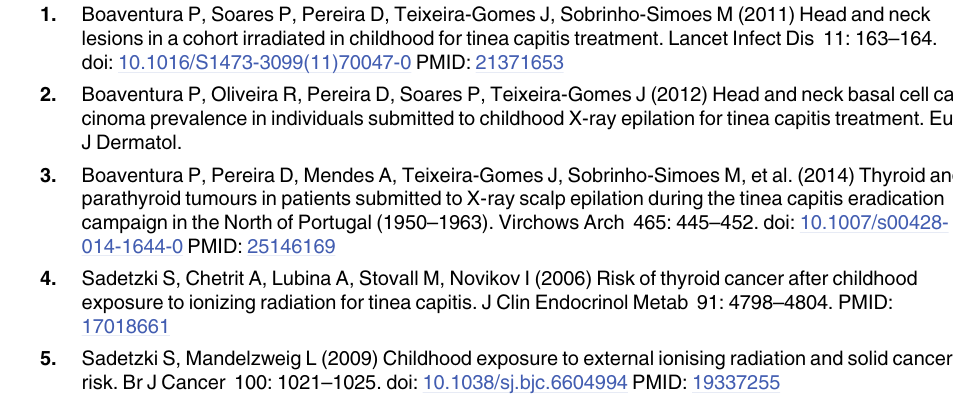
S3 Table. P-values obtained for the adjustment variables in the hereditarymodels analyzed in the atherosclerosisstudy (non-irradiatedgroup). S4 Table. P-values obtained for the adjustment variables in the hereditarymodels analyzed in the atherosclerosisstudy (irradiated